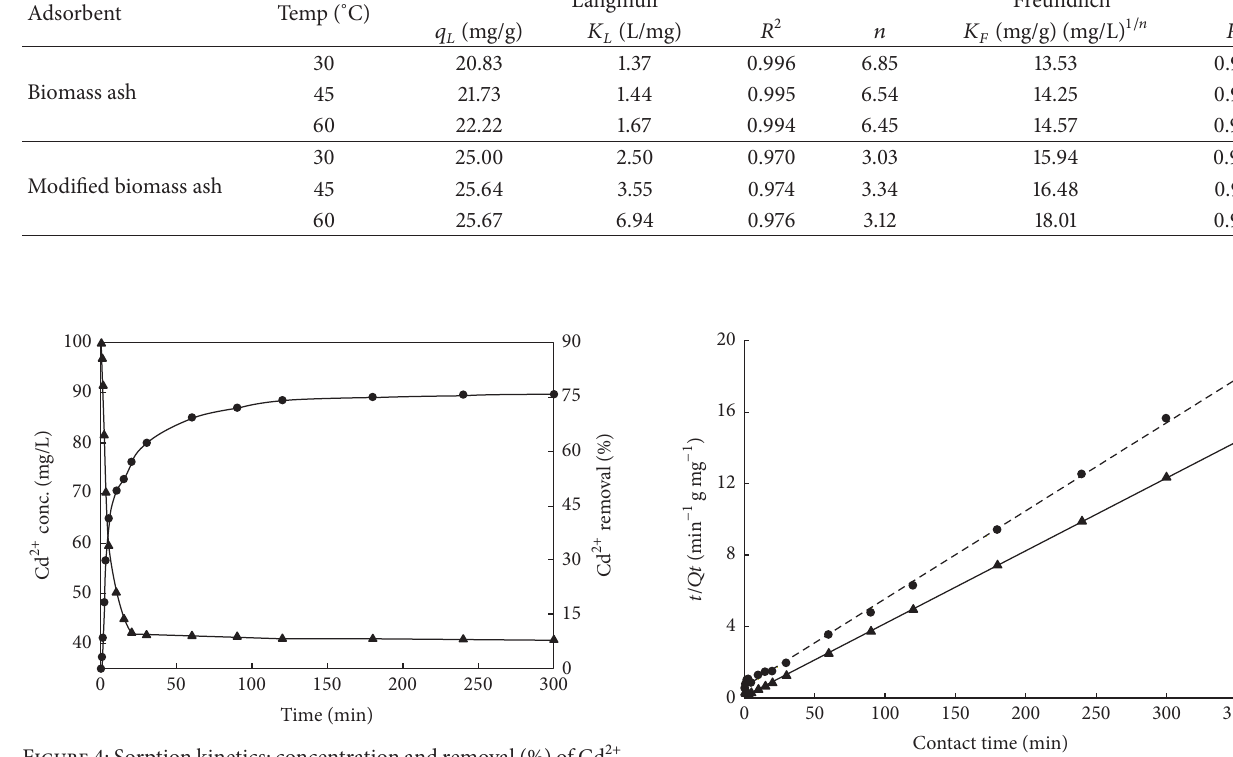
Figure 4: Sorption kinetics: concentration and removal (%) of Cd 2+ from aqueous solution versus sorption time (initial concentrations ofCd 2+ ,100 mg/L;biomassashconcentration,2 g/L; 𝑇 =30 ∘ C;initial pH 5.0).